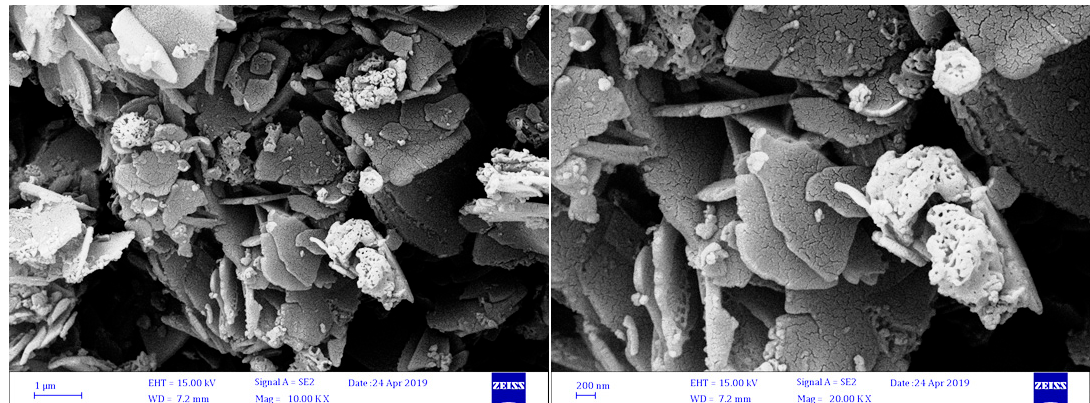
Figure 2. Field emission-scanning electron microscope (FESEM) images of 1 .